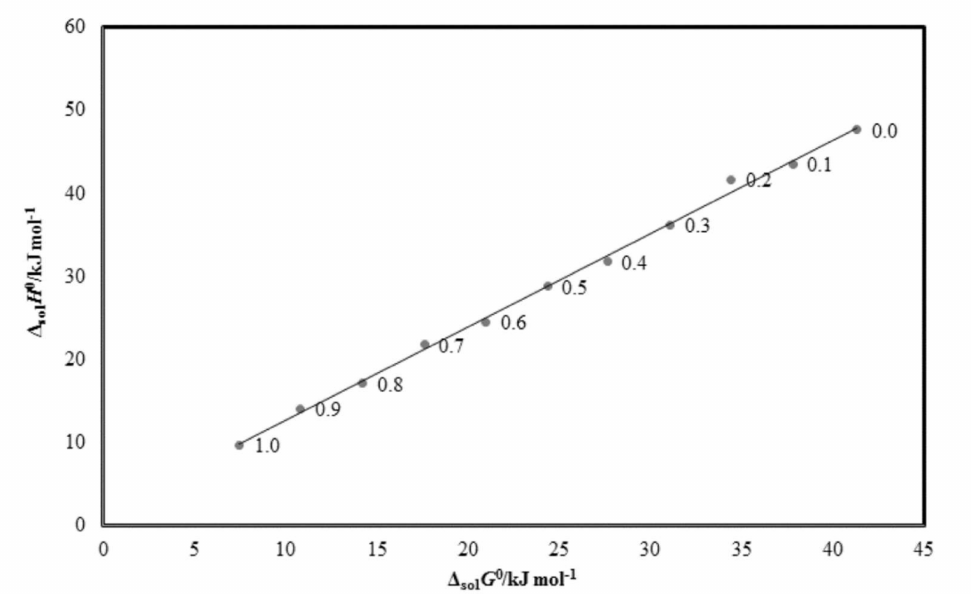
Figure 4. ∆ sol H ◦ vs. ∆ sol G ◦ enthalpy–entropy compensation plot for solubility of CNZ in various {TP (1) + water (2)} mixtures at T hm = 303.0